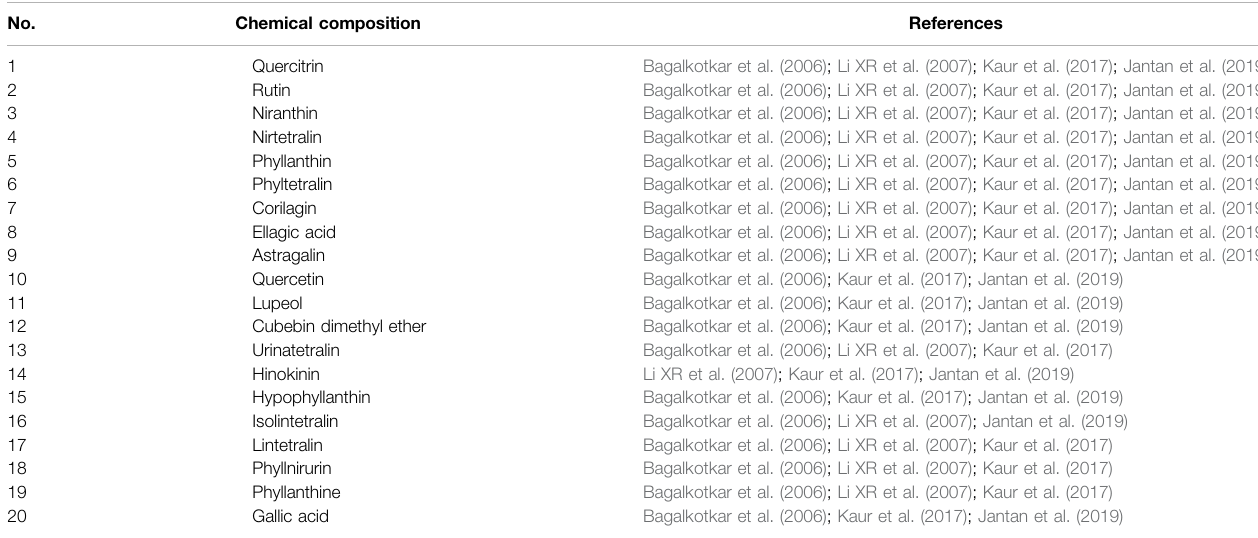
TABLE 1 | List of the 20 active ingredients of Phyllanthus niruri